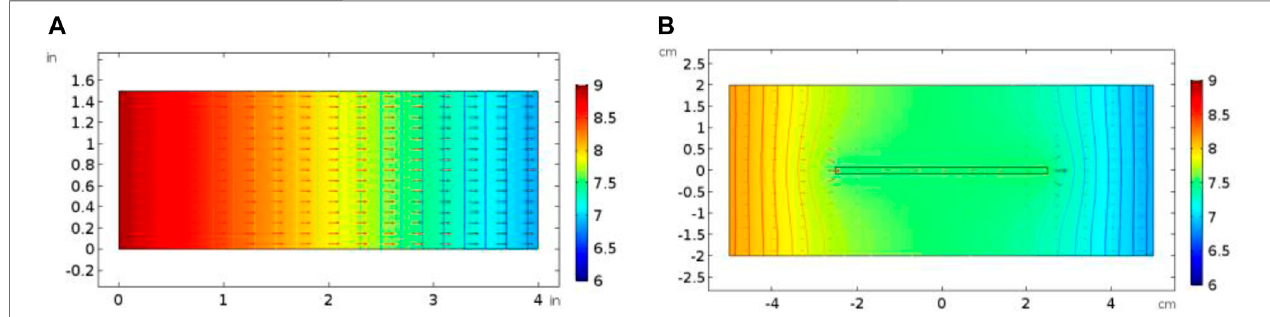
FIGURE 7 | Comparison of velocity and pressure pro fi les with acid injection rate at 0.01 cm/s: (A) matrix core sample; (B) isolated fracture core sample.